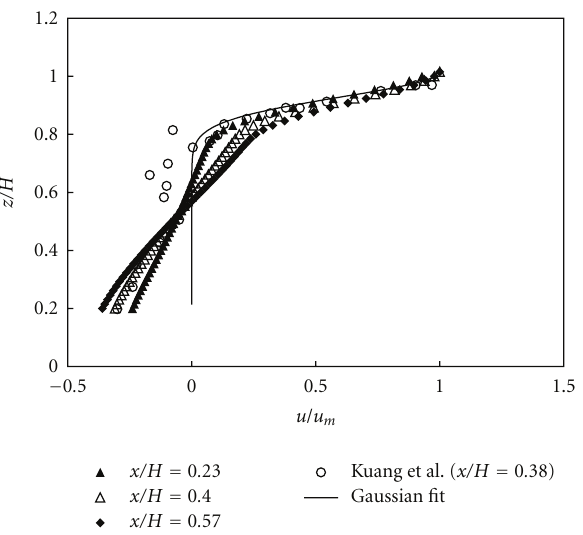
Figure 17: Decay of maximum lateral velocity in